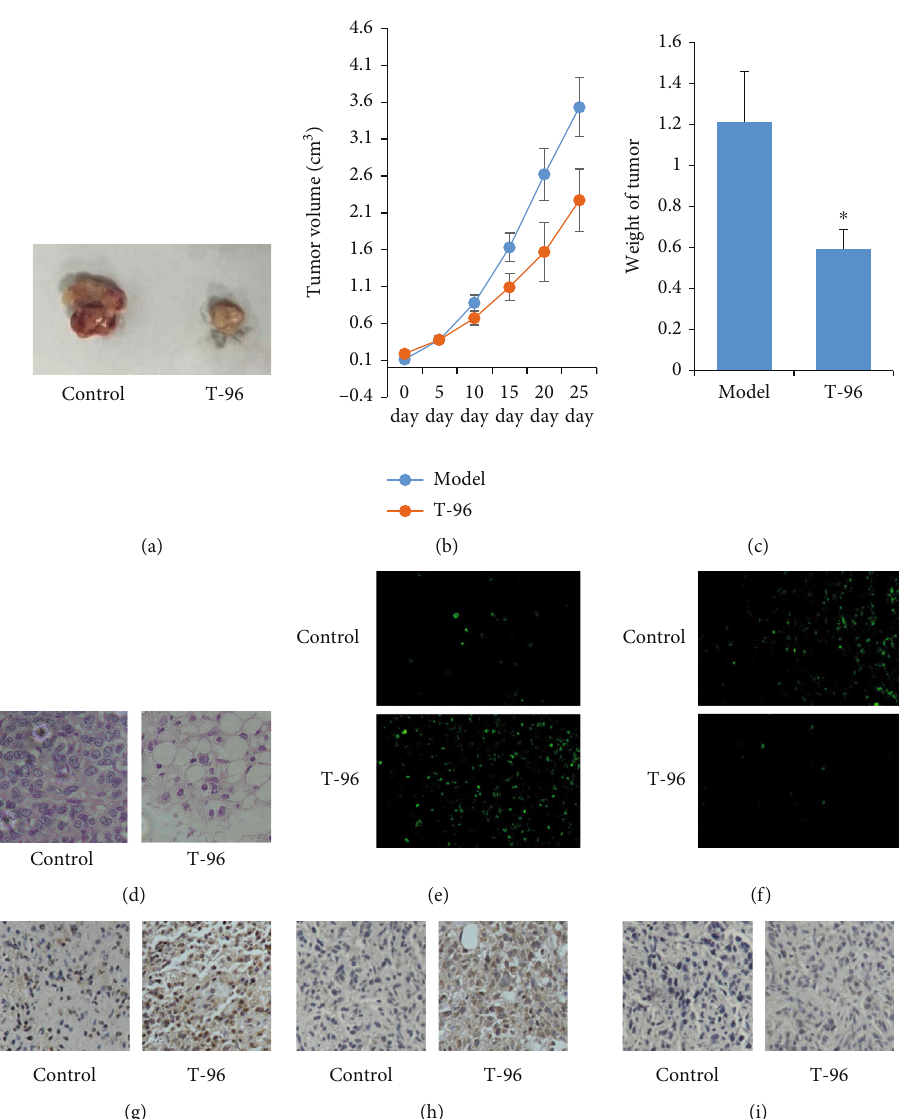
Figure 5: T-96-induced antitumor e ff ects in mice. (a – d) T-96 inhibited SUM1315 cell proliferation in vivo ; (e), T-96 induced SUM-1315 cells apoptosis by TUNEL; (f), T-96 decreased Ki-67 protein expression in SUM-1315 cells by immuno fl uorescence assay; (g and h) T-96 increased histone methylation by immunohistochemical assay; (i), T-96 increased PTEN protein expression in SUM-1315 cell by immunohistochemical assay. Values are statistically signi fi cant at ∗ P < 0 : 05